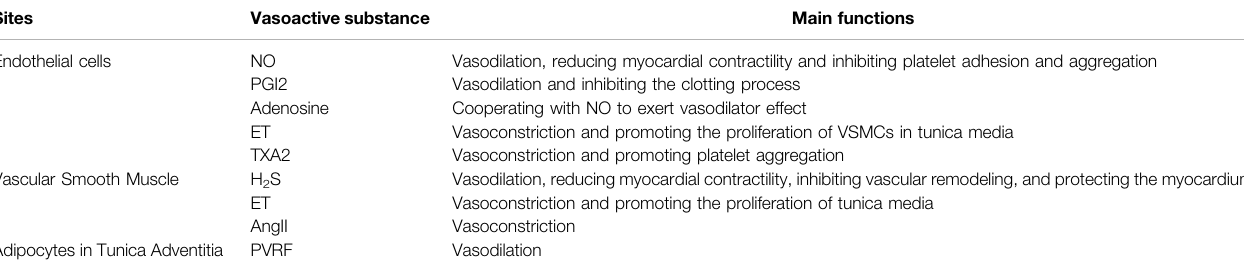
TABLE 1 | Vasoactive substance synthesized by cells in the arterial wall. Sites